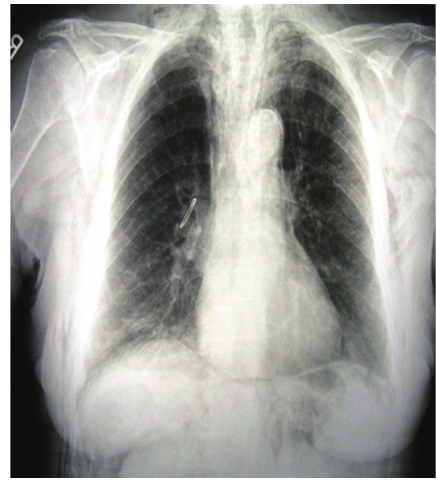
Figure 2: Chest X-ray demonstrating di ff use subcutaneous emphy- sema, pneumomediastinum, and subdiaphragmatic free air.